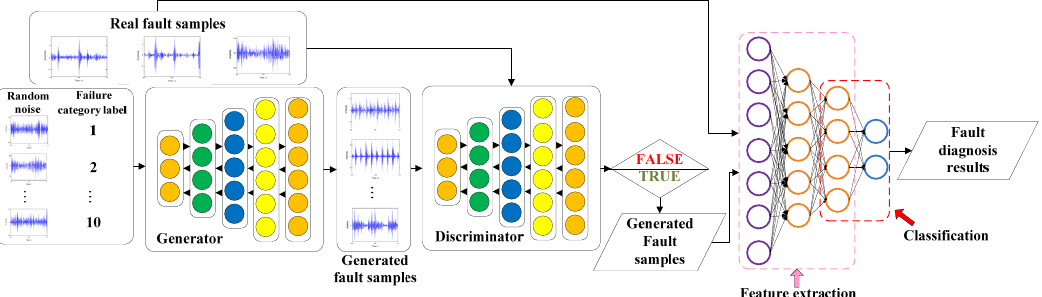
Figure 10. Waterfall model fusion for the GAN ‐ SDAE system.